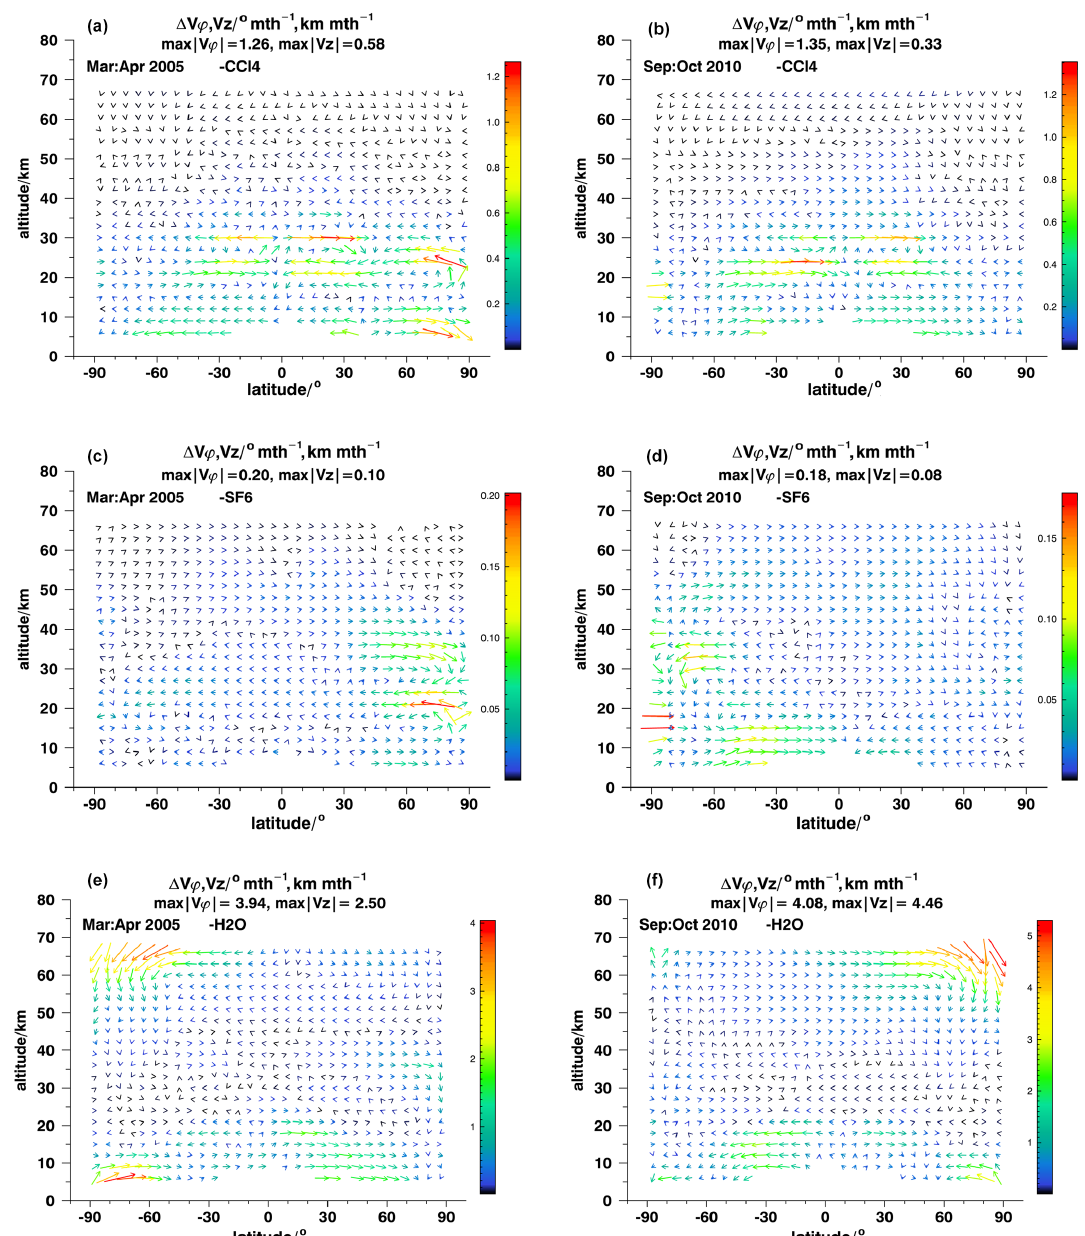
Figure 9. Differences between ANCISTRUS runs with one species omitted and all nine species included for March–April 2005 (a, c, e) and September–October 2010 (b, d, f) . The missing species are CCl 4 (a, b) , SF 6 (c, d) , and H 2 O (e, f)